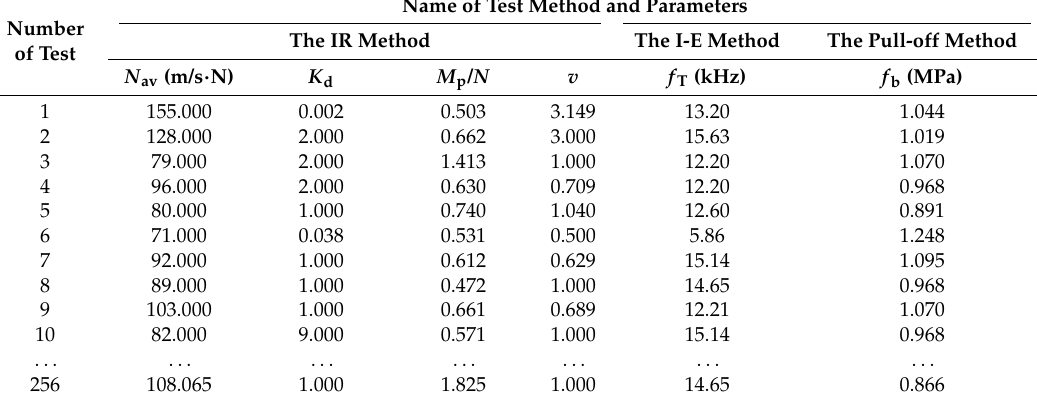
Table 2. Exemplary